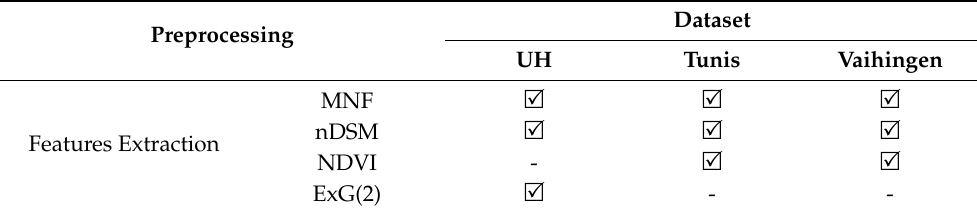
Table 6. Hand-crafted features for all datasets.